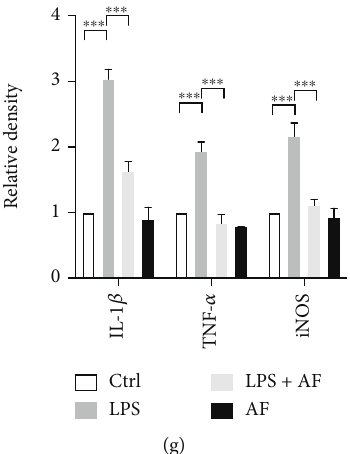
Figure 3: E ff ects of amento fl avone on LPS-induced in fl ammatory response in BV2 microglia cells. (a, b) Semiquantitative analysis of the relative levels of IL-1 β and TNF- α using ELISA. (c) Semiquantitative analysis of the relative levels of NO. (d) Representative images of immuno fl uorescence staining of IL-1 β in BV2 microglial cells. (e) Semiquantitative analysis of the relative levels of IL-1 β in (d) by densitometric analysis. (f) Representative immunoblots of IL-1 β , TNF- α , and iNOS protein in BV2 microglial cells. (g) Semiquantitative analysis of the relative level of IL-1 β , TNF- α , and iNOS by densitometric analysis. Error bars represent mean ± s : d . ∗∗∗ represent P < 0 : 001 , respectively. All experiments were performed in triplicate. LPS: lipopolysaccharide; AF: amento fl